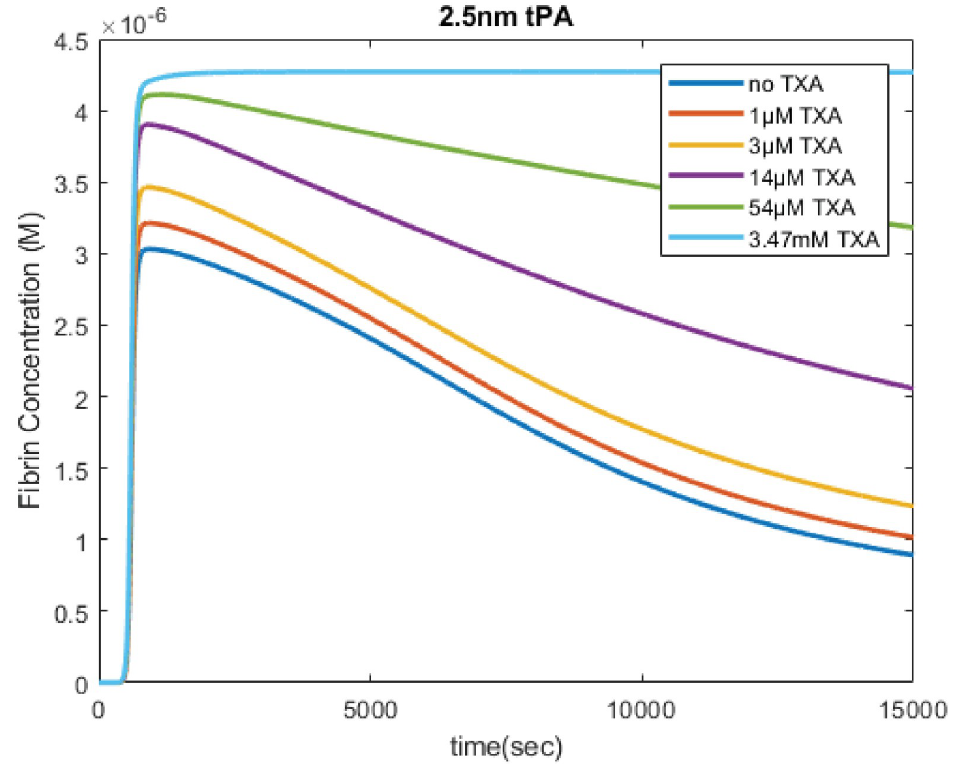
Fig 4. Effects of TXA on tPA mediated fibrinolysis. Modeling results show that Tranexamic Acid (TXA) affects tPA mediated fibrinolysis in a dose dependent fashion. As the concentration of TXA increases, the rate of fibrinolysis decreases. At the highest dose of TXA, fibrinolysis appears to be completely inhibited. These simulations are initiated with 5 pM tissue factor, and an initial tPA concentration of 2.5 nM.